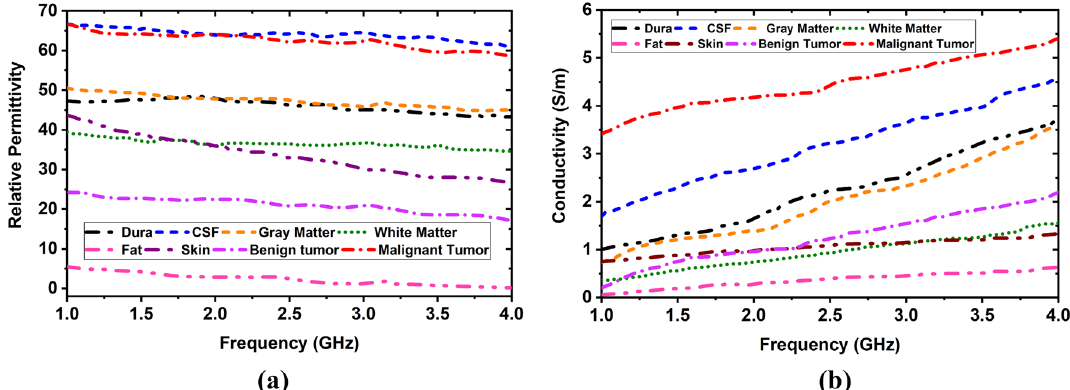
Figure 24. Measured results of dielectric properties of the fabricated tissues: ( a ) Relative permittivity; ( b ) Conductivity.